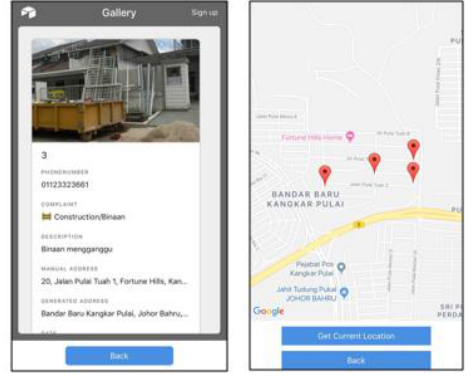
Figure 9. The information of the sent data can be view in the